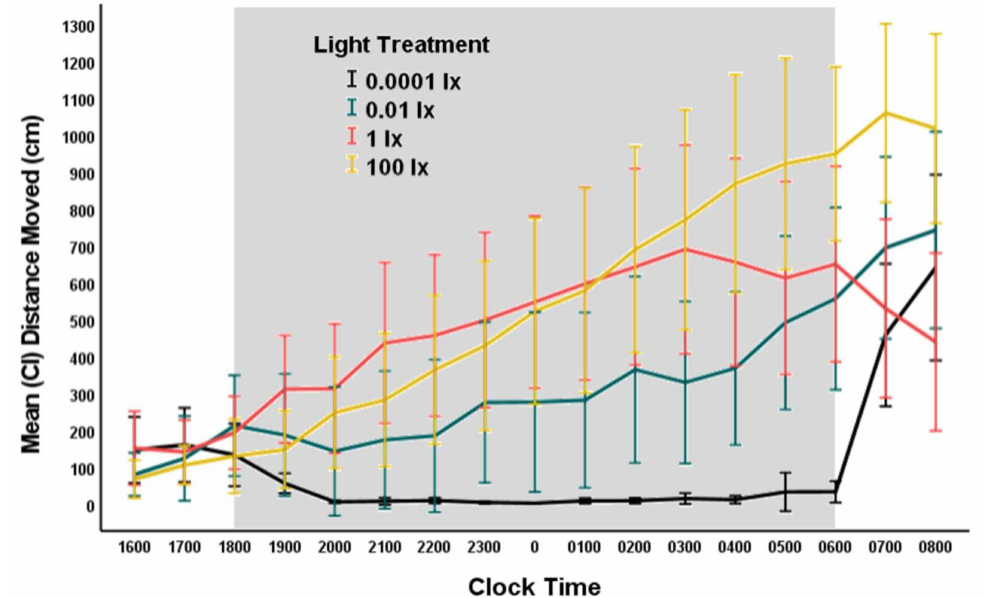
Figure 5. Movement of fruit flies in each nocturnal light treatment (0.0001, 0.01, 1, and 100 lx) at 1-h-intervals starting 2 h before lights off (1800 h) until 2 h after light on (0600 h). Time on x-axis represent the starting time of the 1-h-interval. The error bars represent 95%